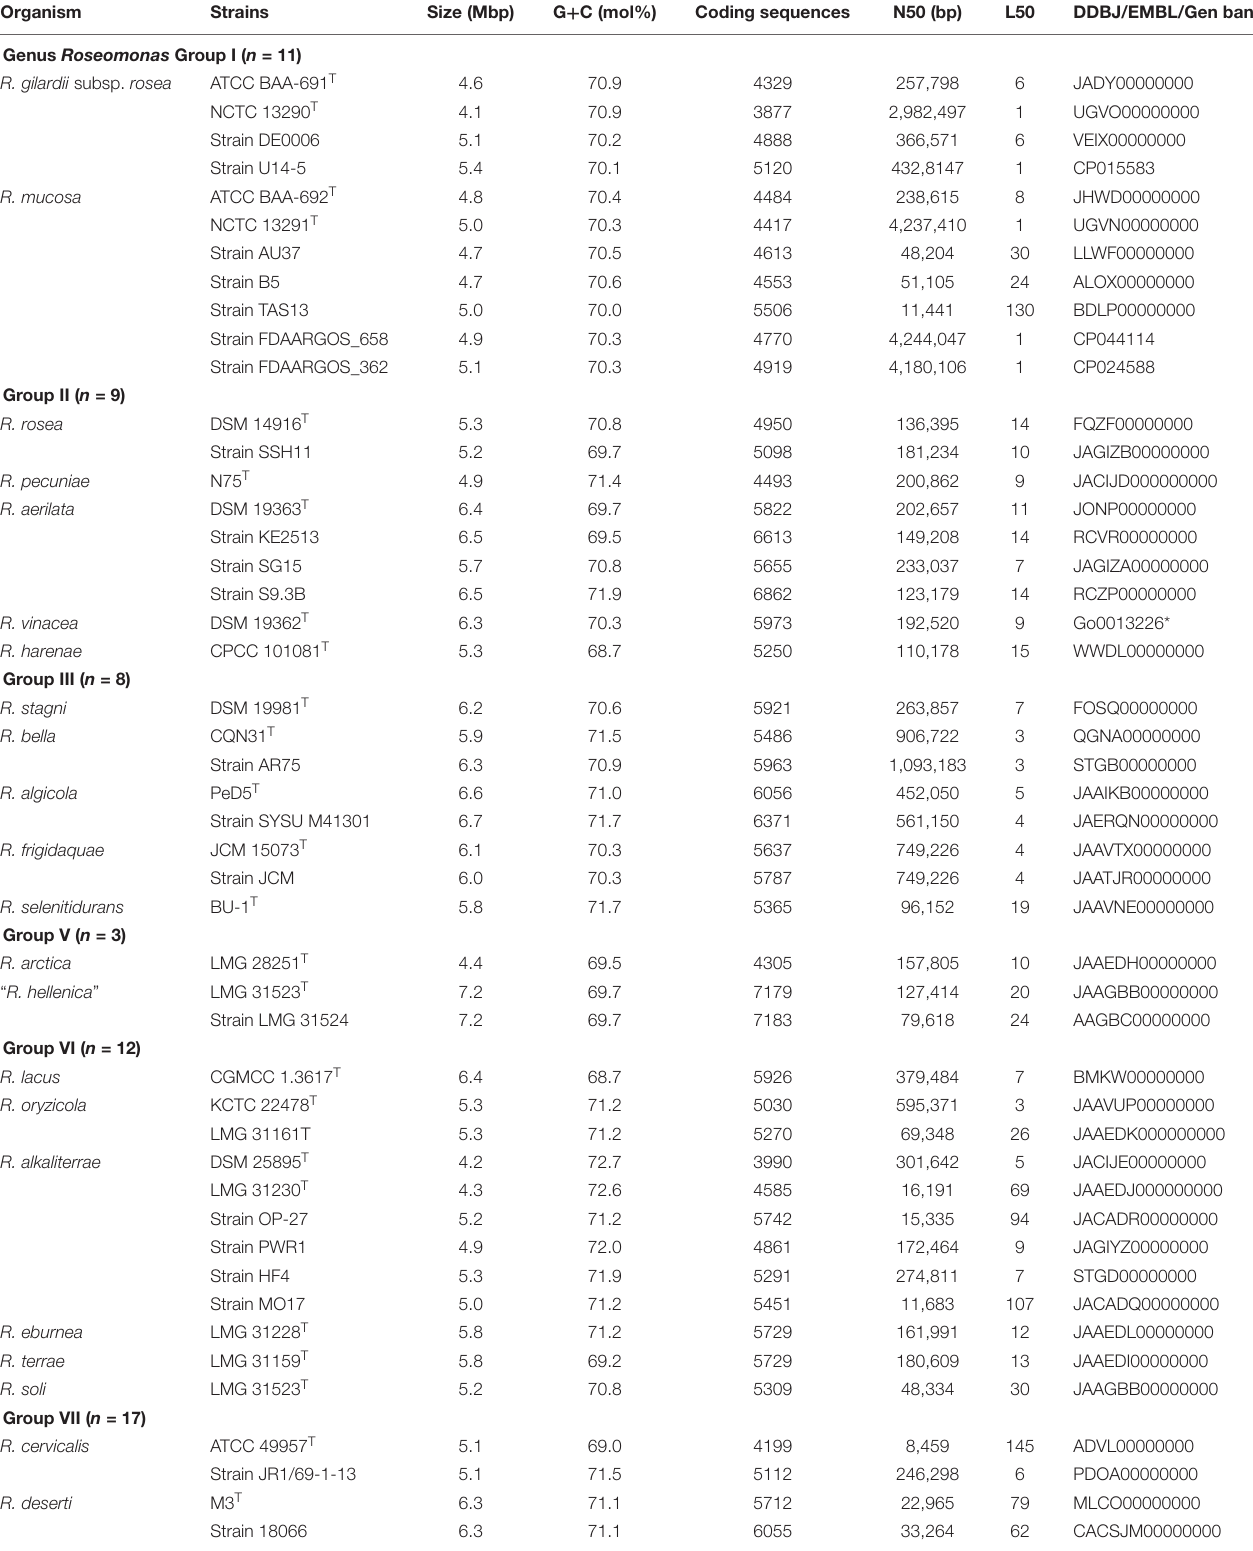
TABLE 1 | Genome characteristics of the members of the genus Roseomonas and closely related strains in the family Acetobacteraceae. Organism Strains Size (Mbp) G + C (mol%) Coding sequences N50 (bp) L50 DDBJ/EMBL/Gen